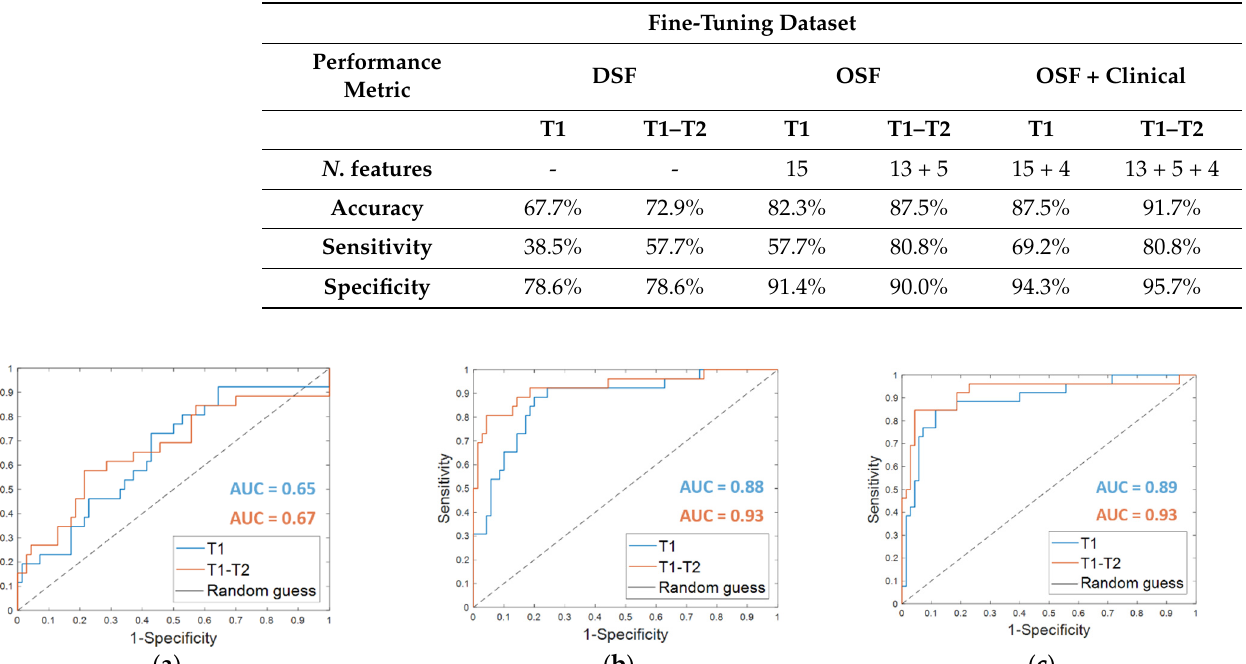
Table 2. Summary of the performances of the breast cancer recurrence prediction models on the fine- tuning dataset in terms of accuracy, sensitivity, and specificity, using the Dynamically Selected Features (DSF), the Optimal Subset of Features (OSF), also combined with the clinical features (OSF + clinical), respectively. The features were selected for the exams at timepoint T1 alone or at timepoints T1–T2 simultaneously (original model). The numbers of features selected for OSF and OSF + clinical are also highlighted. The numbers of DSF features are omitted because they vary from one patient to another.